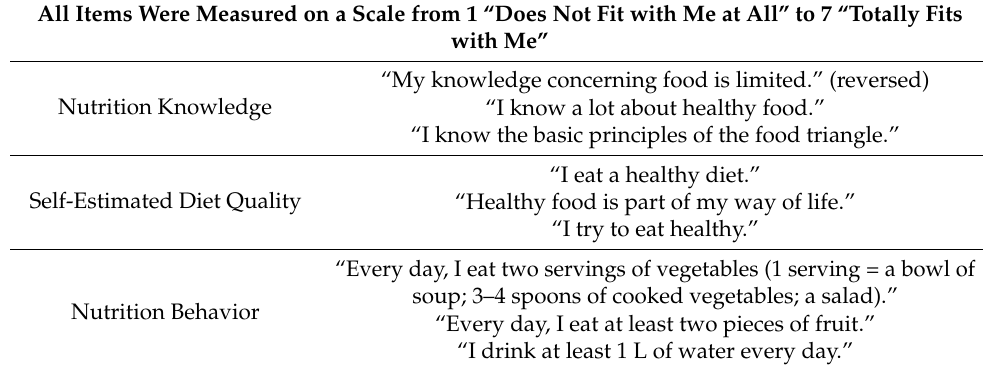
Table A2. Scale items nutrition knowledge, self-estimated diet quality, and nutrition behavior.